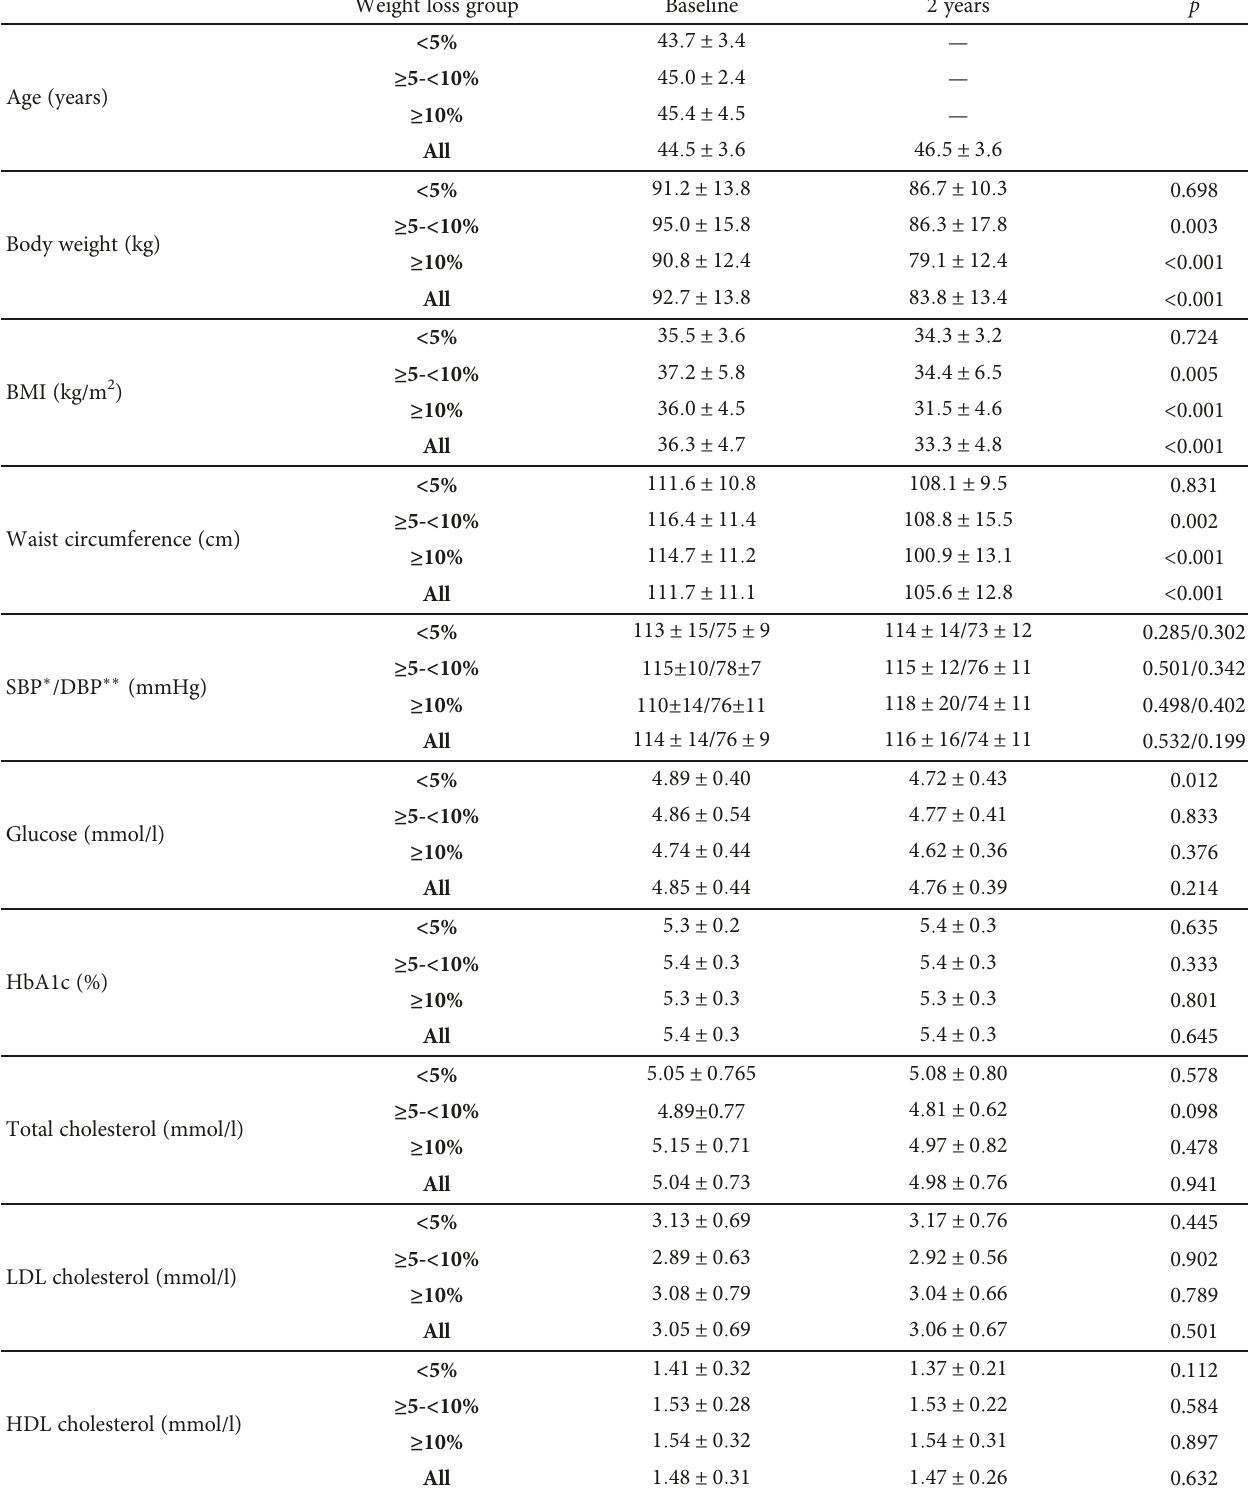
Table 1: Parameters at baseline ( n = 115 MHO participants) vs. after 2 years ( n = 67 MHO participants) of lifestyle modi fi cation, according to percentage of weight